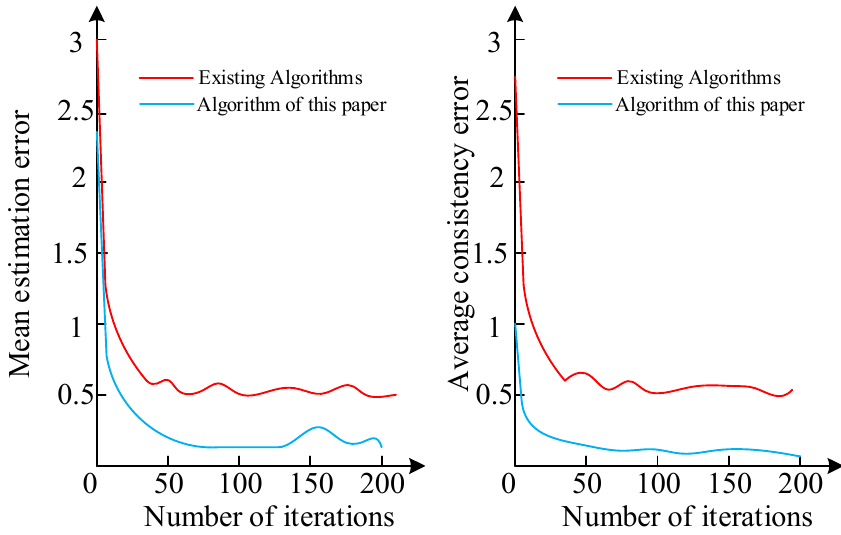
Figure 5. Average estimation error and average consistency error of two algorithms.